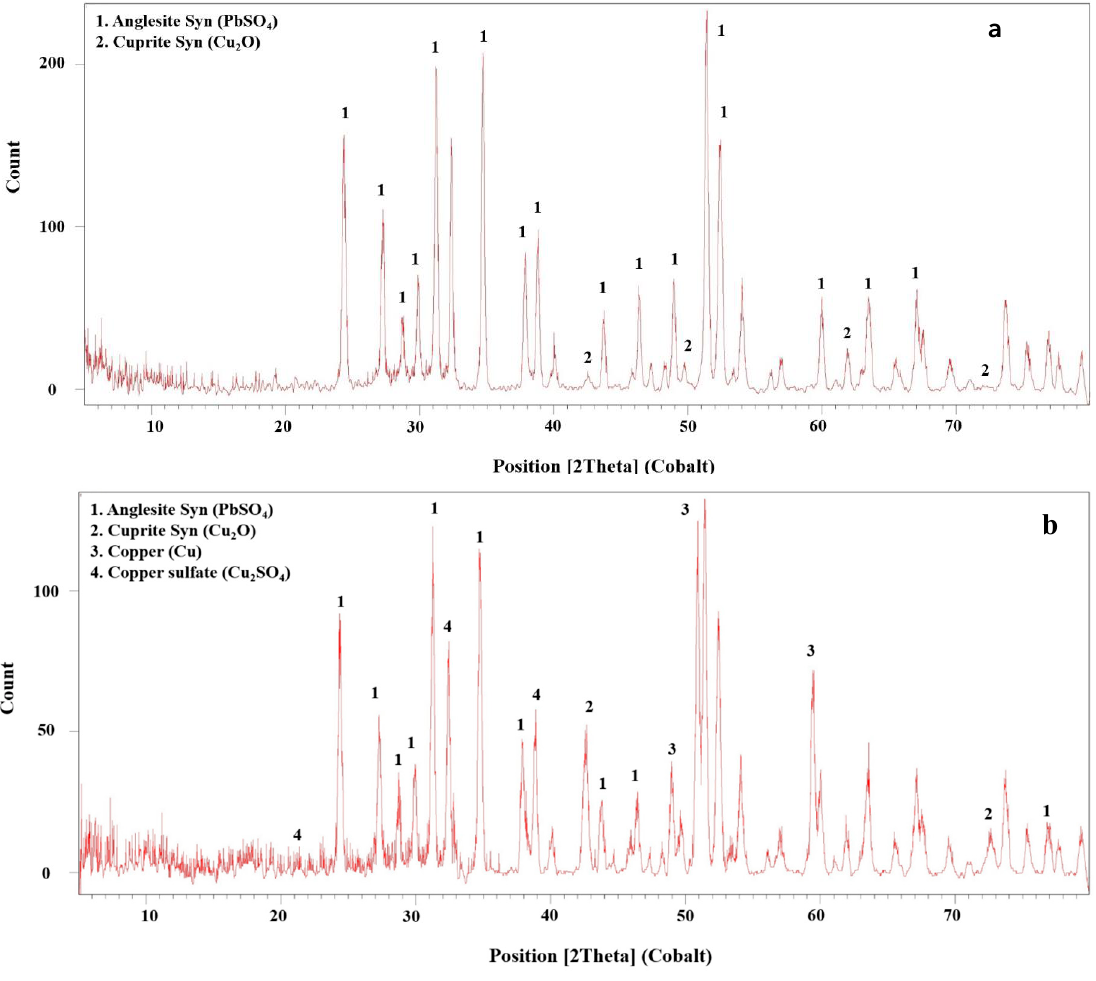
Figure 11. XRD di ff ractogram for microwave leaching ( a ) and non-microwave leaching ( b ) Figure 11. XRD diffractogram for microwave leaching ( a ) and non ‐ microwave leaching ( b ) residuals.